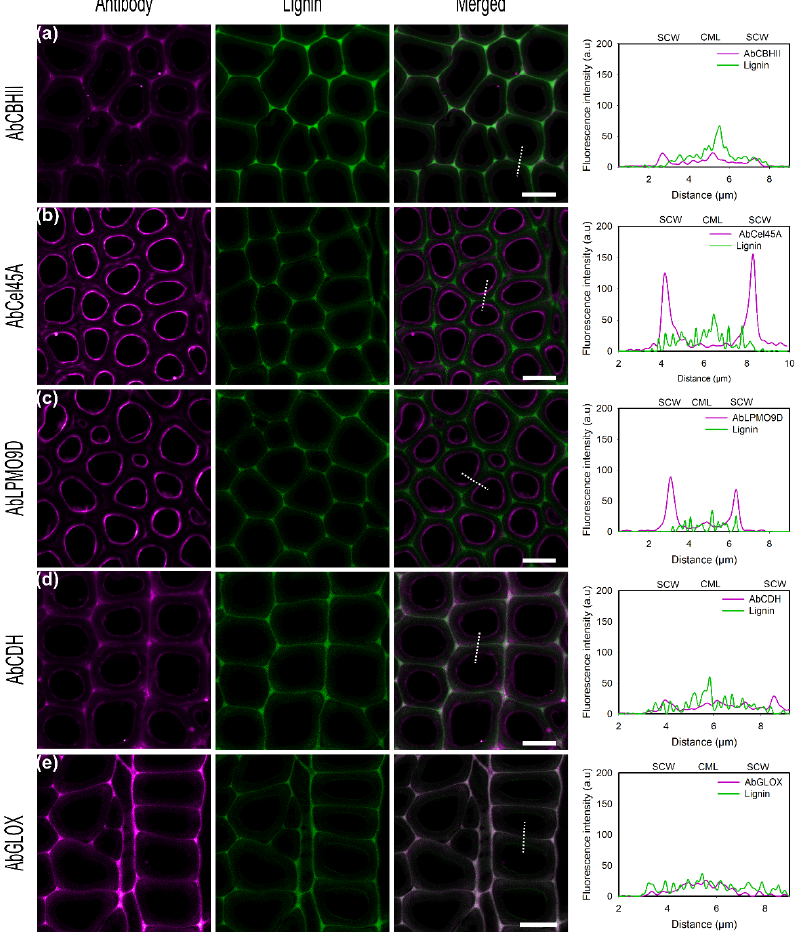
Figure 7. CLSM images of conjugated rabbit polyclonal antibody ( a ) AbCBHII, ( b ) AbCel45A, ( c ) AbLPMO9D, ( d ) AbCDH, ( e ) AbGLOX against P. chrysosporium enzymes on delignified poplar cross-sections showing fiber cells. Enzyme fluorescence is colored in magenta. Lignin autofluores- cence is shown in green. The merged column displays the overlay of enzyme and autofluorescence channels. Graphs show the overlay profile (dash line) of line scans over the fiber cell wall, showing secondary cell walls (SCW) and compound middle lamella (CML). Scale bars correspond to 10 µm.